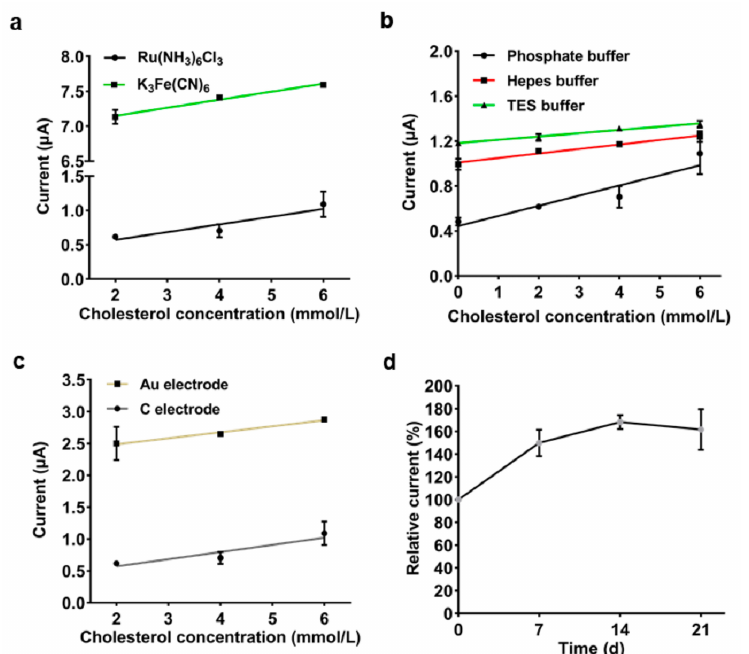
Figure 5. Characterization of the whole-cell cholesterol biosensor. ( a – c ) Effect of ( a ) electron mediator, ( b ) buffer and ( c ) electrode material on the cholesterol biosensor. ( d ) Storage stability of the optimized cholesterol biosensor. Electrochemical detection parameters: voltage 0.3 V, acquisition time 30 s. Error bars indicate the SD of samples tested in